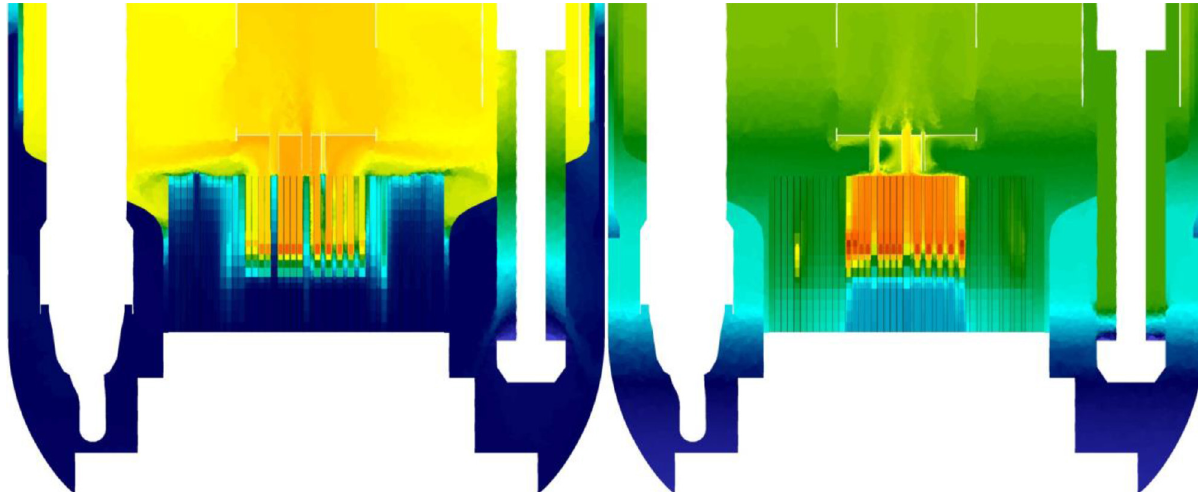
Fig. 4. Nominal and natural convection states (subchannel calculation in the core, CFD calculation in the plena and inter-wrapper region) (cid:1) color is related to temperature scale as illustrative purpose;red-700K,